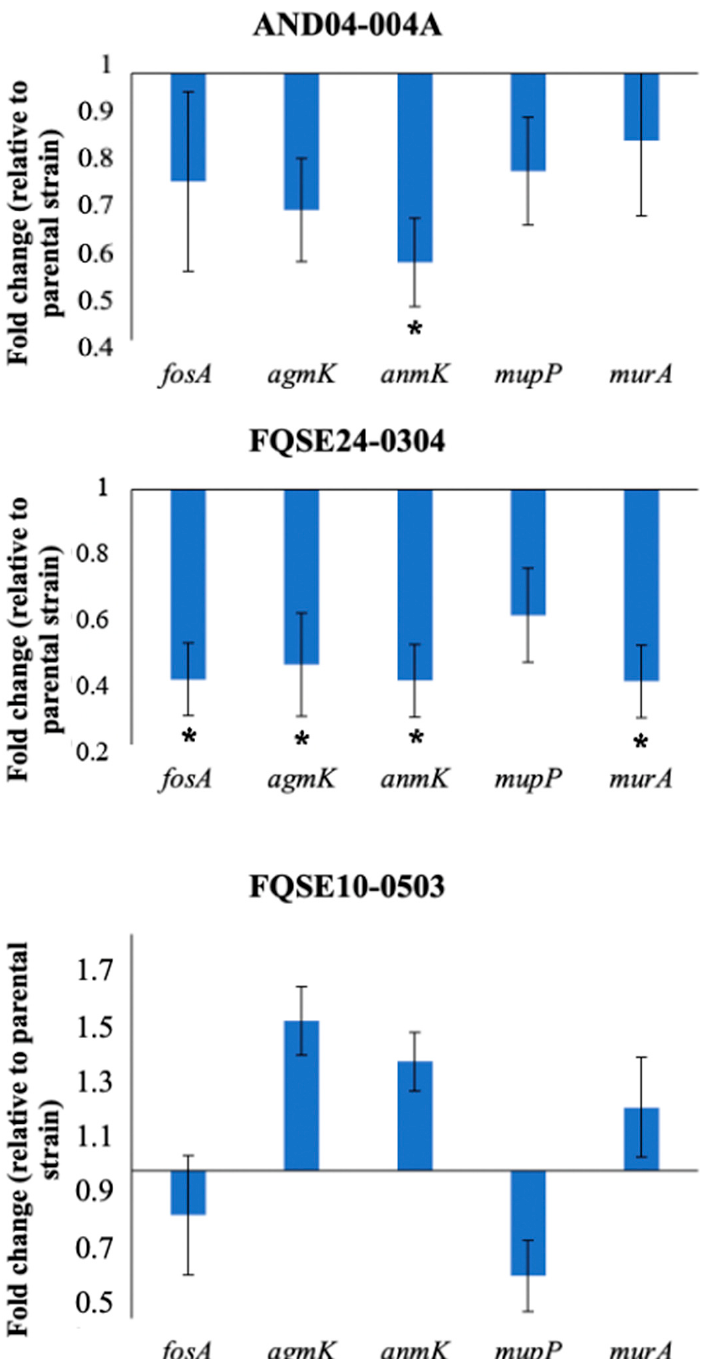
Figure 4. fosA, agmK, anmK , mupP, and murA expression in evolved AND04-004A, FQSE24-0304, and FQSE10-0503 single clones compared with parental ones. Fold change of various genes’ expression level in clones from populations evolved in the presence of tobramycin respect to their parental strains’ is represented. Error bars indicate standard deviations of the results from three biological replicates. Statistically significant differences between the parental strain and the evolved clones were calculated with t-test for paired samples assuming equal variances: * p < 0.05.